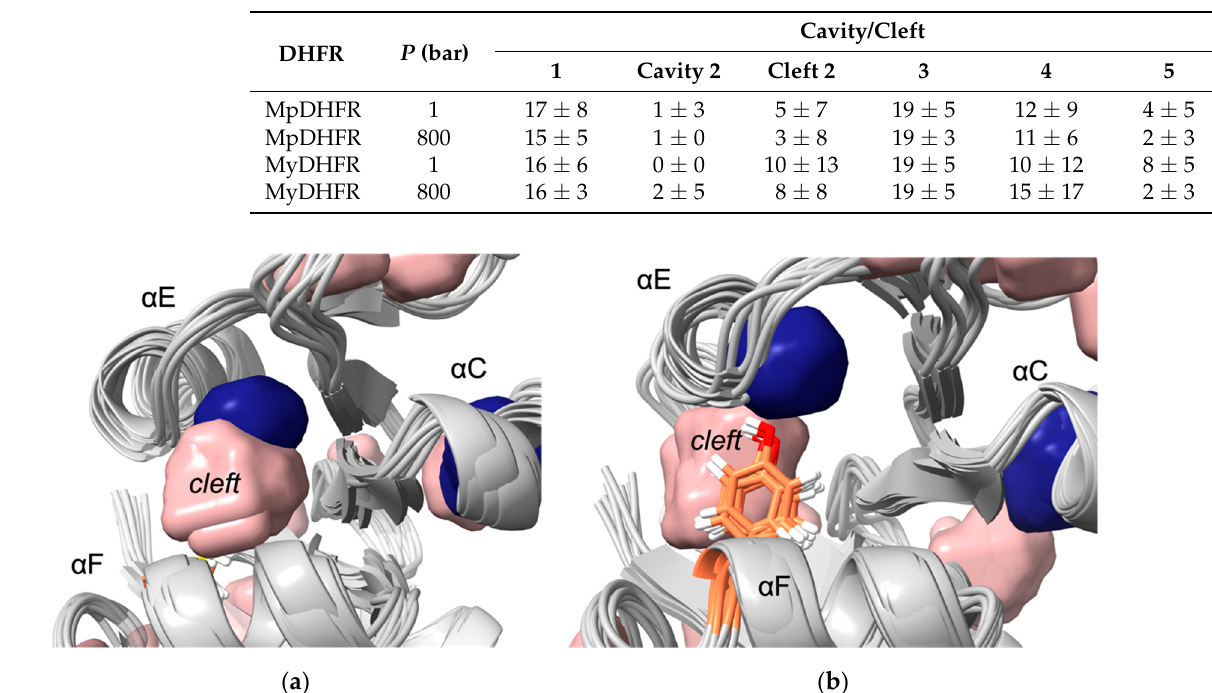
Table 3. Average and RMS fluctuations cavity or cleft volumes, V cav (Å 3 ).